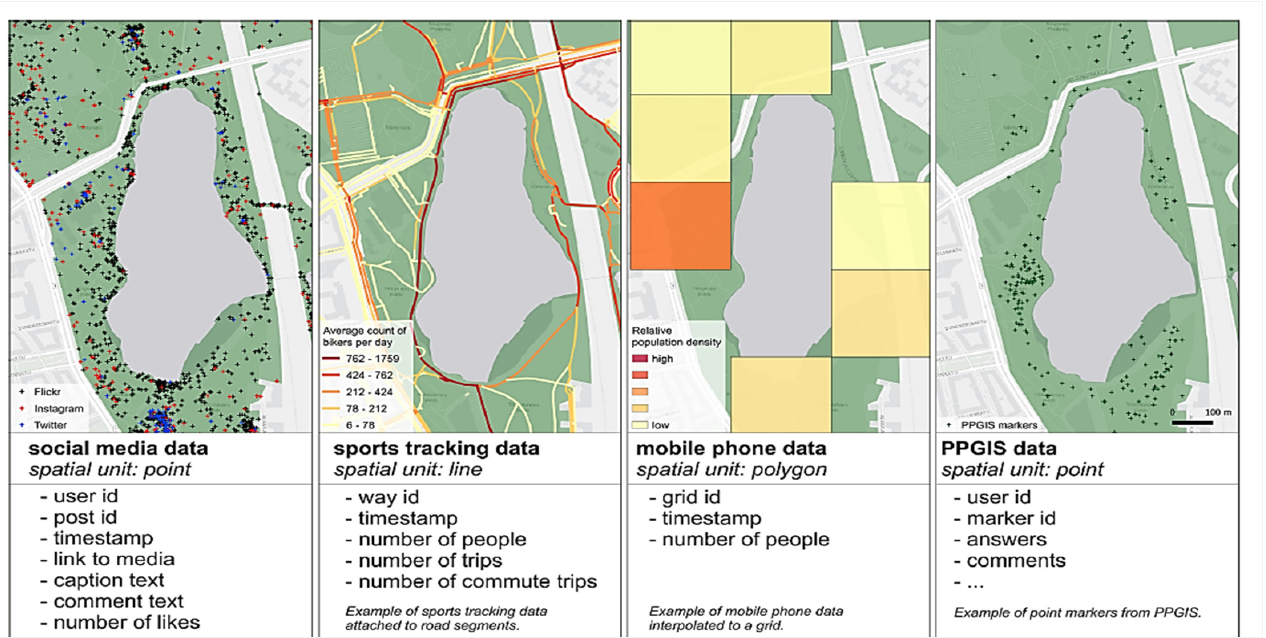
Figure 10. User-generated data for urban spatial analysis. Source: [70].